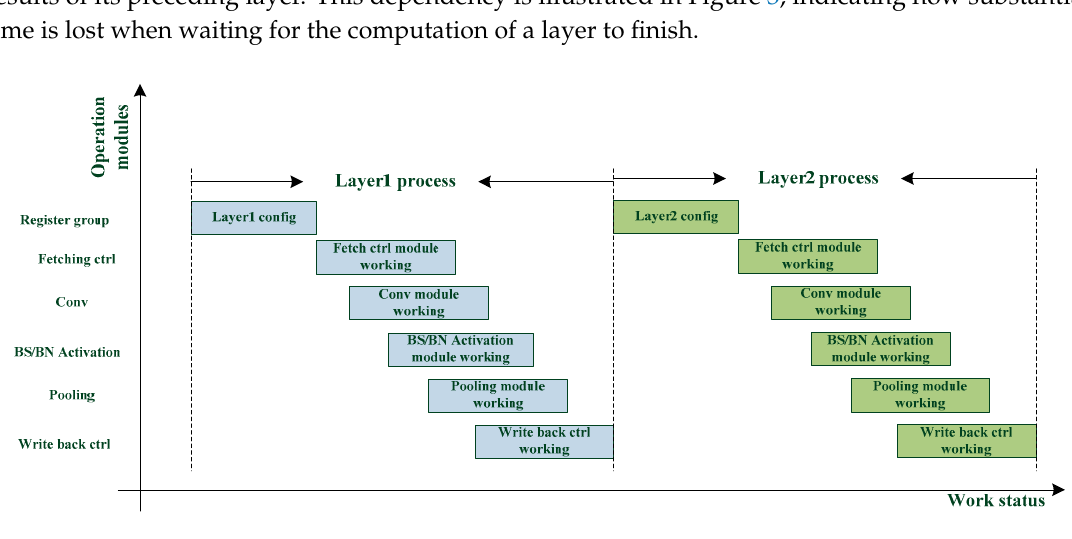
Figure 2. Quantization operation unit structure diagram.